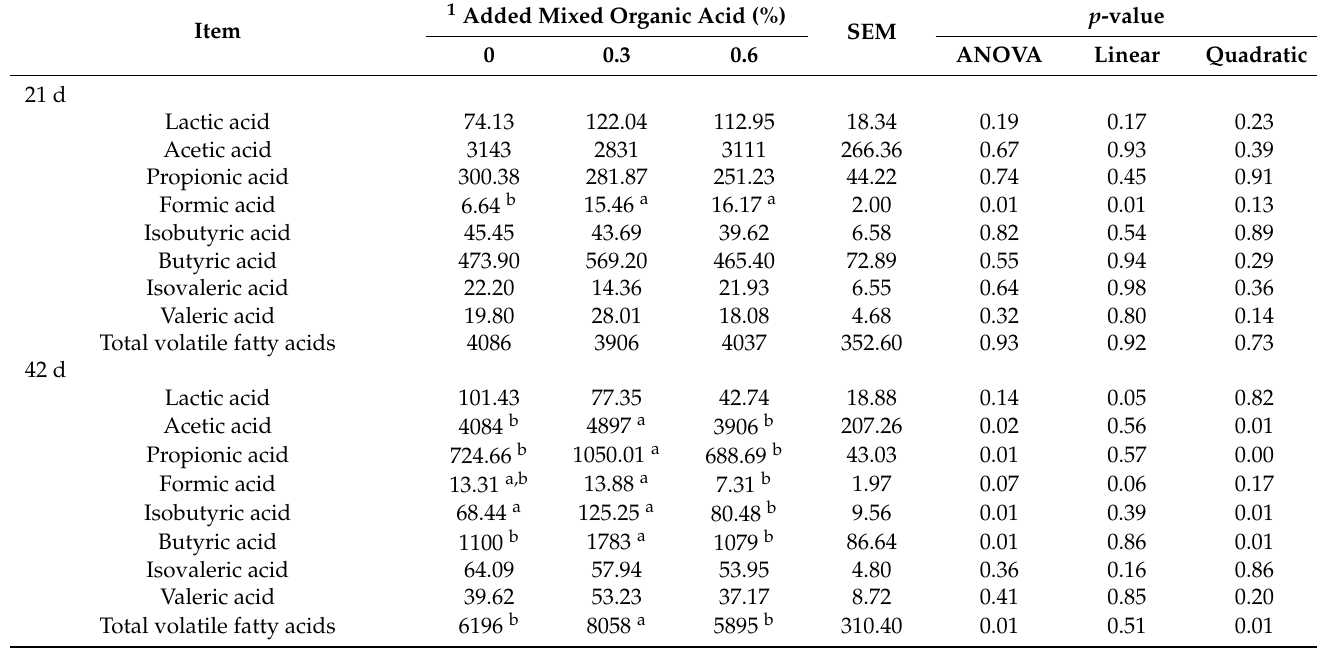
Table 8. Volatile fatty acids in cecum content of 21 d and 42 d broiler chickens as affected by dietary MOA supplementation